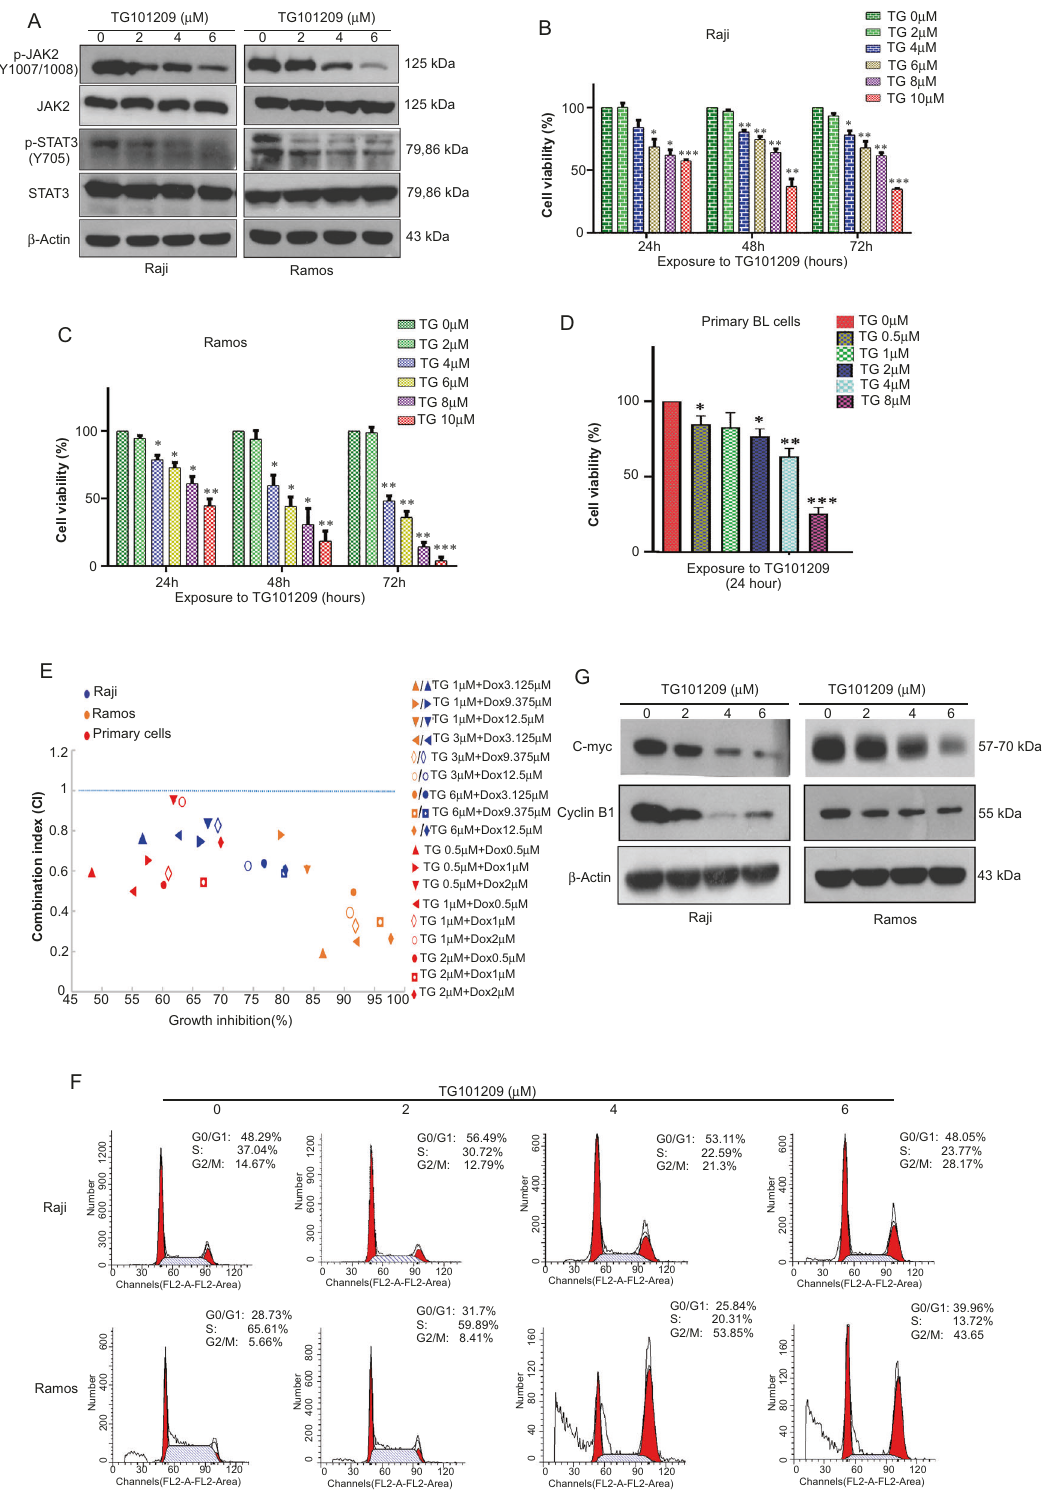
Fig. 1 TG101209 inhibits the proliferation of BL cells and induces G2/M cell cycle arrest. A Western blot analysis was performed to detect the expression of JAK2, p-JAK2, STAT3 and p-STAT3 in BL cells treated with the indicated concentrations of TG101209 for 0.5 h to con fi rm the effect of TG101209 on the JAK/STAT3 signaling pathway. Raji ( B ), Ramos ( C ) and primary BL cells ( D ) were treated with TG101209 at different concentrations for indicated time, and cell viability was determined by MTT assay. E Combination index (CI) value of TG101209 and doxorubicin was calculated using the method as described in Materials and methods. Drug synergy, addition, and antagonism are de fi ned by CI values less than 1.0, equal to 1.0, or greater than 1.0, respectively. F Flow cytometric analysis of the cell cycle in Raji and Ramos cells exposed to TG101209 for 48 h. G Western blot analysis was performed to detect the expression of c-Myc and cyclin B1 in BL cells treated with the indicated concentrations of TG101209 for 48 h. The data represent the mean ± SEM of three different experiments. * p < 0.05, ** p < 0.01 and *** p < 0.001 compared with the negative control (Student ’ s t